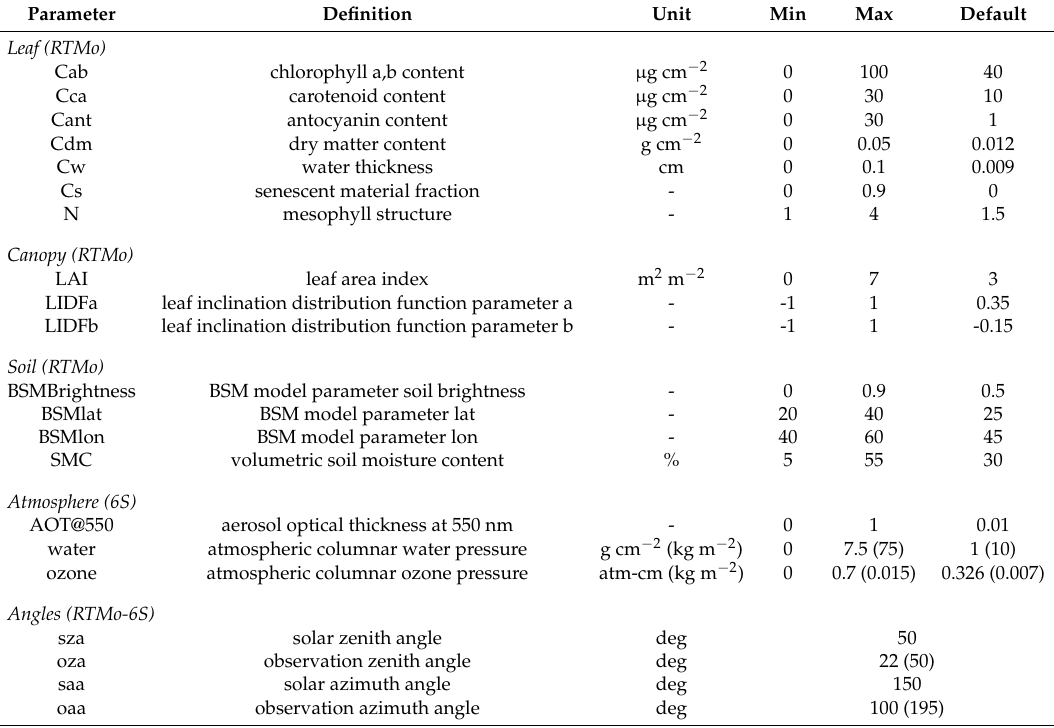
Table 1. Ranges of parameters used in global sensitivity analysis (GSA) of coupled RTMo-6S model. Angles in brackets are related to the oblique view. Values for water and ozone are in default 6S units (Sentinel-3 OLCI product units). Fixed 6S parameters are listed in Table